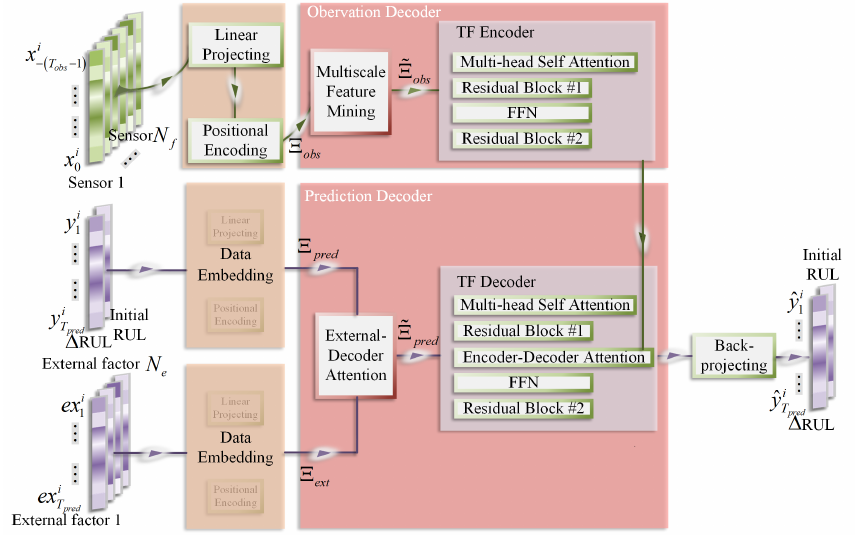
Figure 4. Model illustration of the proposed multilevel fusion transformer